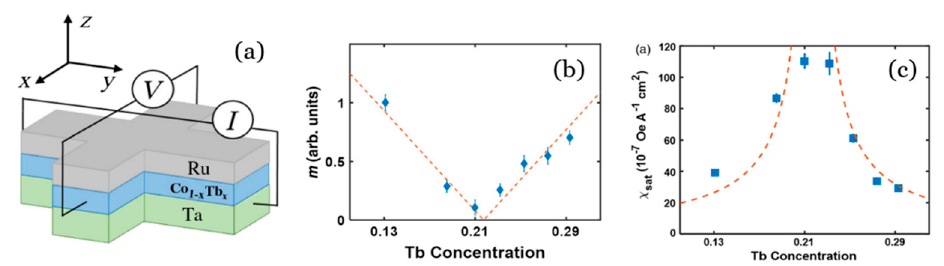
Figure 9. ( a ) Schematics of the device geometry for the measurement of anomalous Hall resistance. ( b ) Magnetic moments of Co 1 − x Tb x alloys as a function of Tb concentration showing magnetic compensation. ( c ) Saturation SOT efficiency for different Tb concentration. Reprinted with permission from ref. [75] 2016 APS.